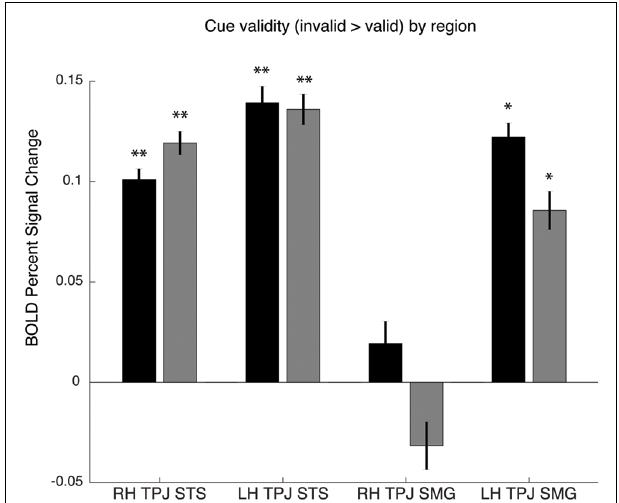
FIGURE 5 | Cue validity effects in oddball-defined regions of interest (ROIs). Individual subject ROIs (black), group-defined ROIs (gray). Percent signal change for invalid vs. valid contrast, ∗ p > 0.05 or ∗∗ p > 0.01.